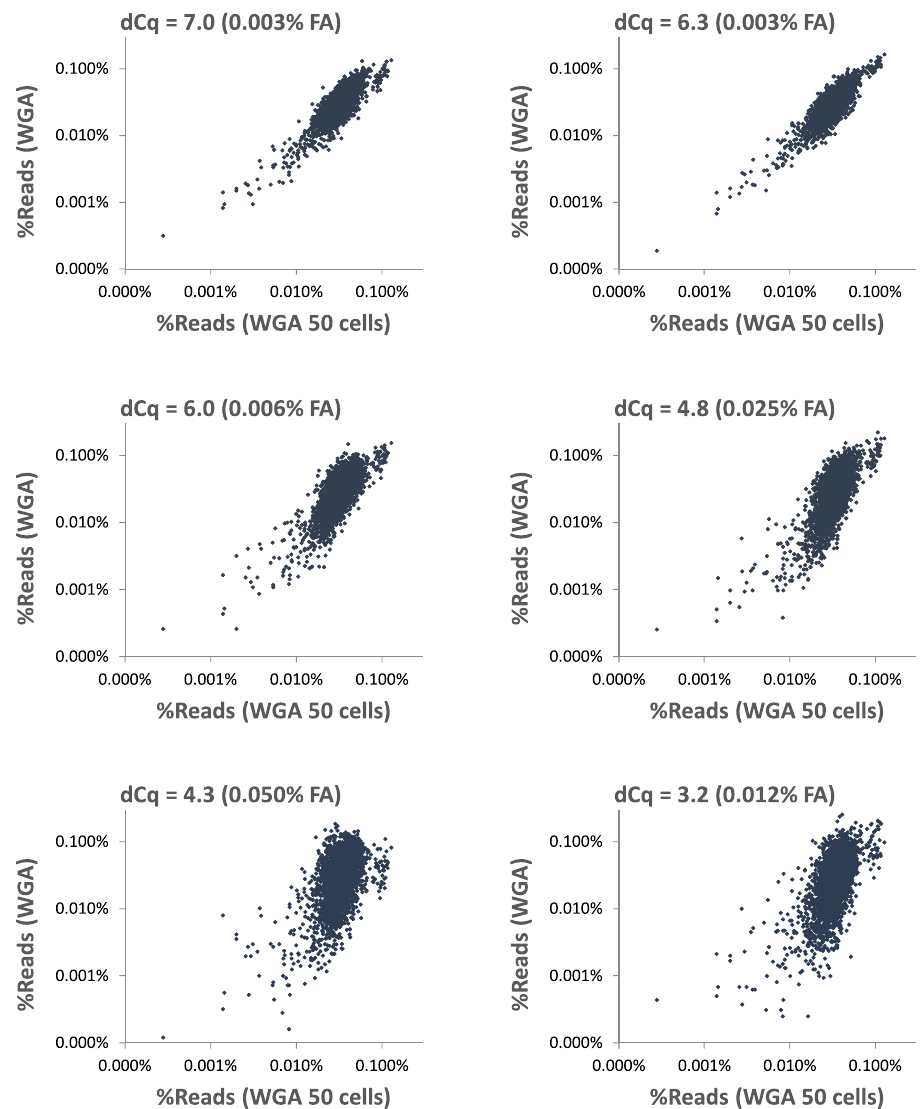
Figure 5. Single cell WGA vs WGA of 50 cells. The figures show scatter plots of relative read counts mapped to human genome 1 mbp bins after WGA sorted according to their dCq value of Control-DNA. On the X-axis relative read counts are represented of WGA reaction of 50 cell sample that were not treated by formaldehyde. On Y-axis, relative read counts are shown of samples with a single formaldehyde treated cell on average. The formaldehyde concentration (FA) is indicated. All WGA reactions were performed in the presence of competing Control-DNA. WGA reactions were selected according to their dCq value of Control-DNA for NGS (see headline of scatter plots). Deviation of read counts correlated with dCq value of Control-DNA after WGA and formaldehyde treatment. The higher the formaldehyde concentration is for DNA damaging within cells, the higher is the deviation of read counts and the lower is the dCq value. Exception is the WGA reaction characterized by a dCq value of 3.2 (last panel). Here, the formaldehyde concentration is intermediate but resulted in high deviations of read counts. It is most likely that this cell was already damaged prior to formaldehyde treatment. Therefore, an intermediate formaldehyde concentration is enough to damage the single cell DNA strongly. However, the dCq value is a good indicator for sequencing outcome also for this